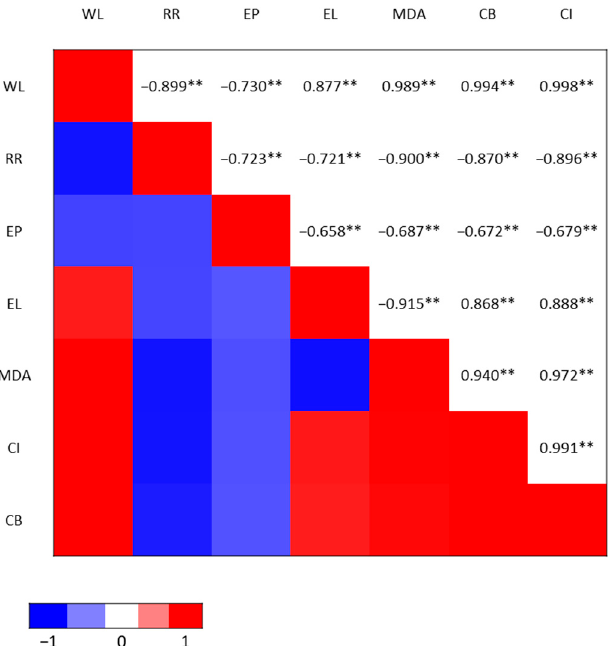
Figure 7. Pearson correlation coefficient heat map of weight loss (WL), respiration rate (RR), ethylene production rate (EP), electrolyte leakage (EL), malondialdehyde (MDA), calyx browning index (CB), and chilling injury index (CI) of fruits pretreated with 10% CO 2 for 12, 24, and 48 h, as well as untreated and modified atmosphere packaging (MAP) with 50,000 cc · m − 2 · day − 1 · atm − 1 OTR film throughout the 15 days of cold storage and 8 days at room temperature. ** indicate correlation is significant at p ˂ 0.01.